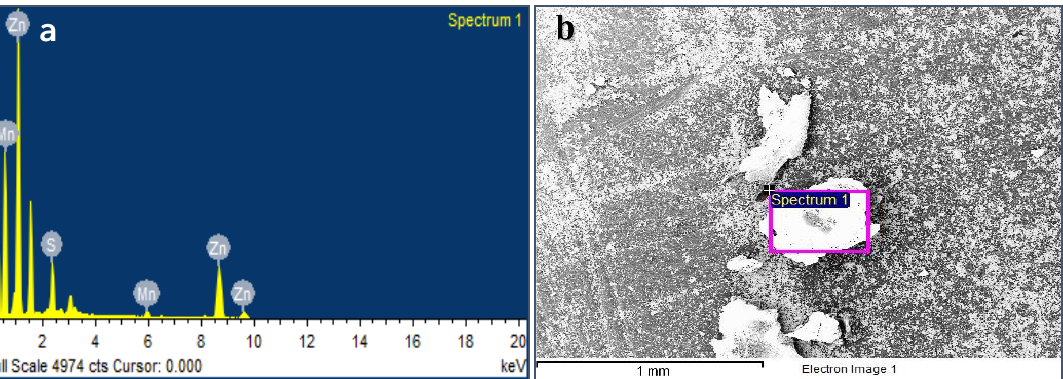
Figure 3. XRD di ff ractogram of Mn:ZnS QDs. Figure 3. XRD diffractogram of Mn:ZnS QDs.